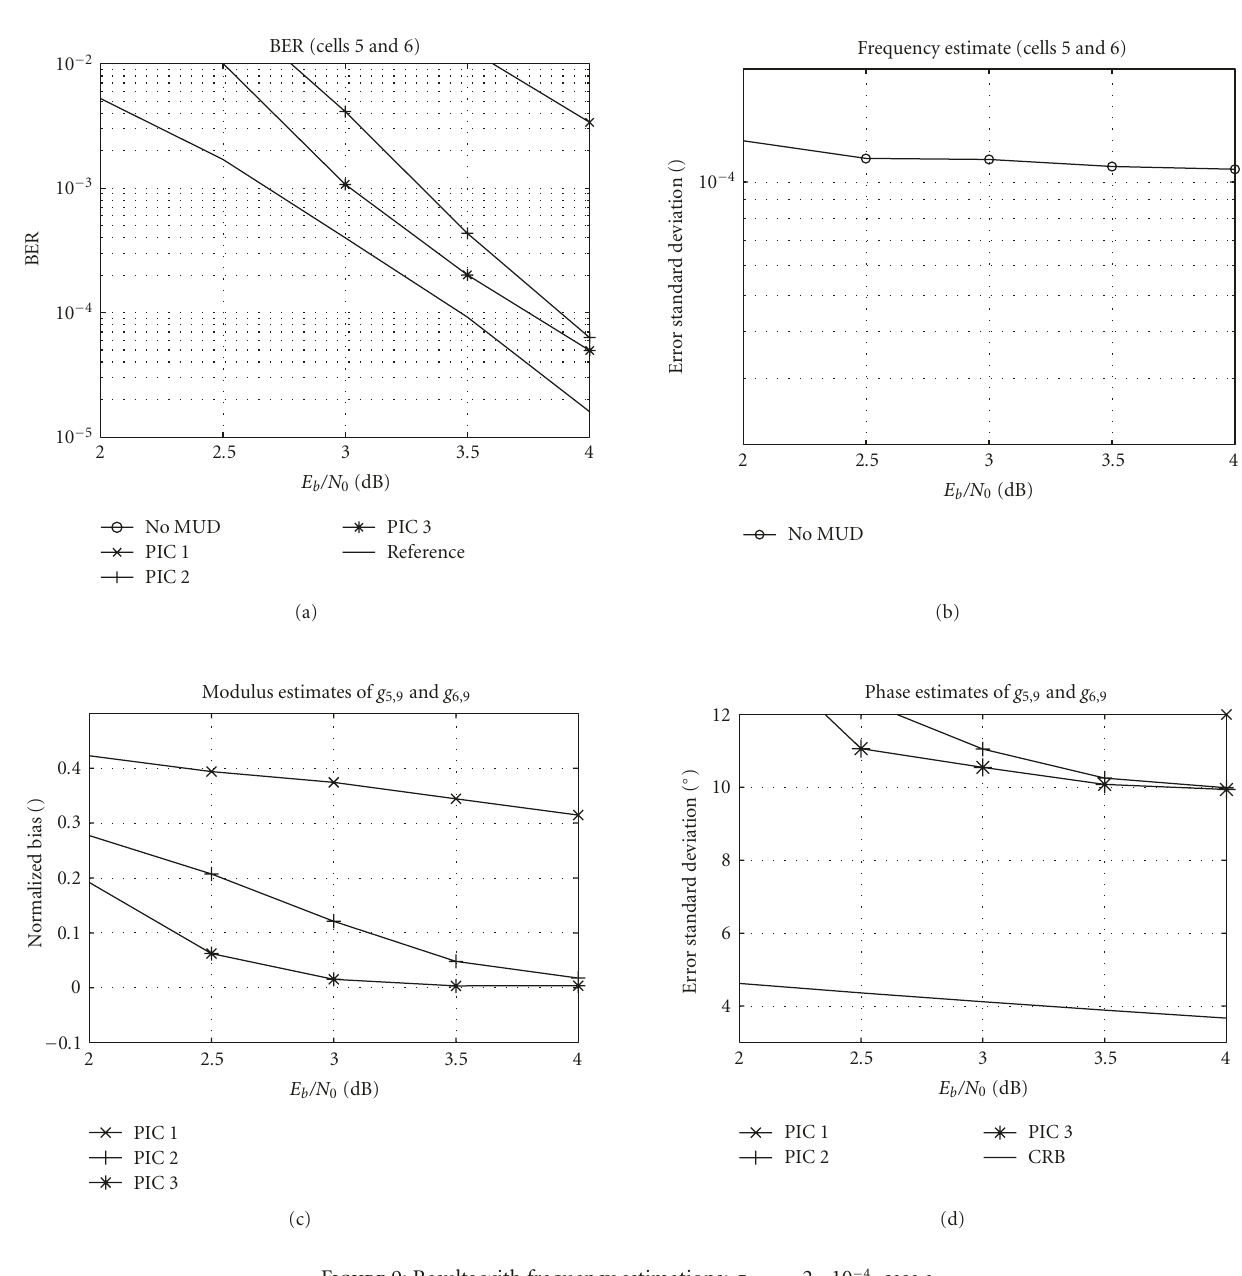
Figure 9: Results with frequency estimations: σ Δ fT = 2 · 10 − 4 , case